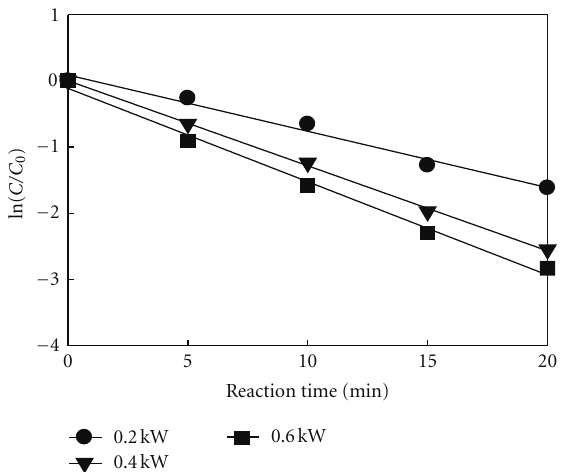
Figure 4: E ff ect of microwave intensity on photocatalytic degrada- tion of RB.